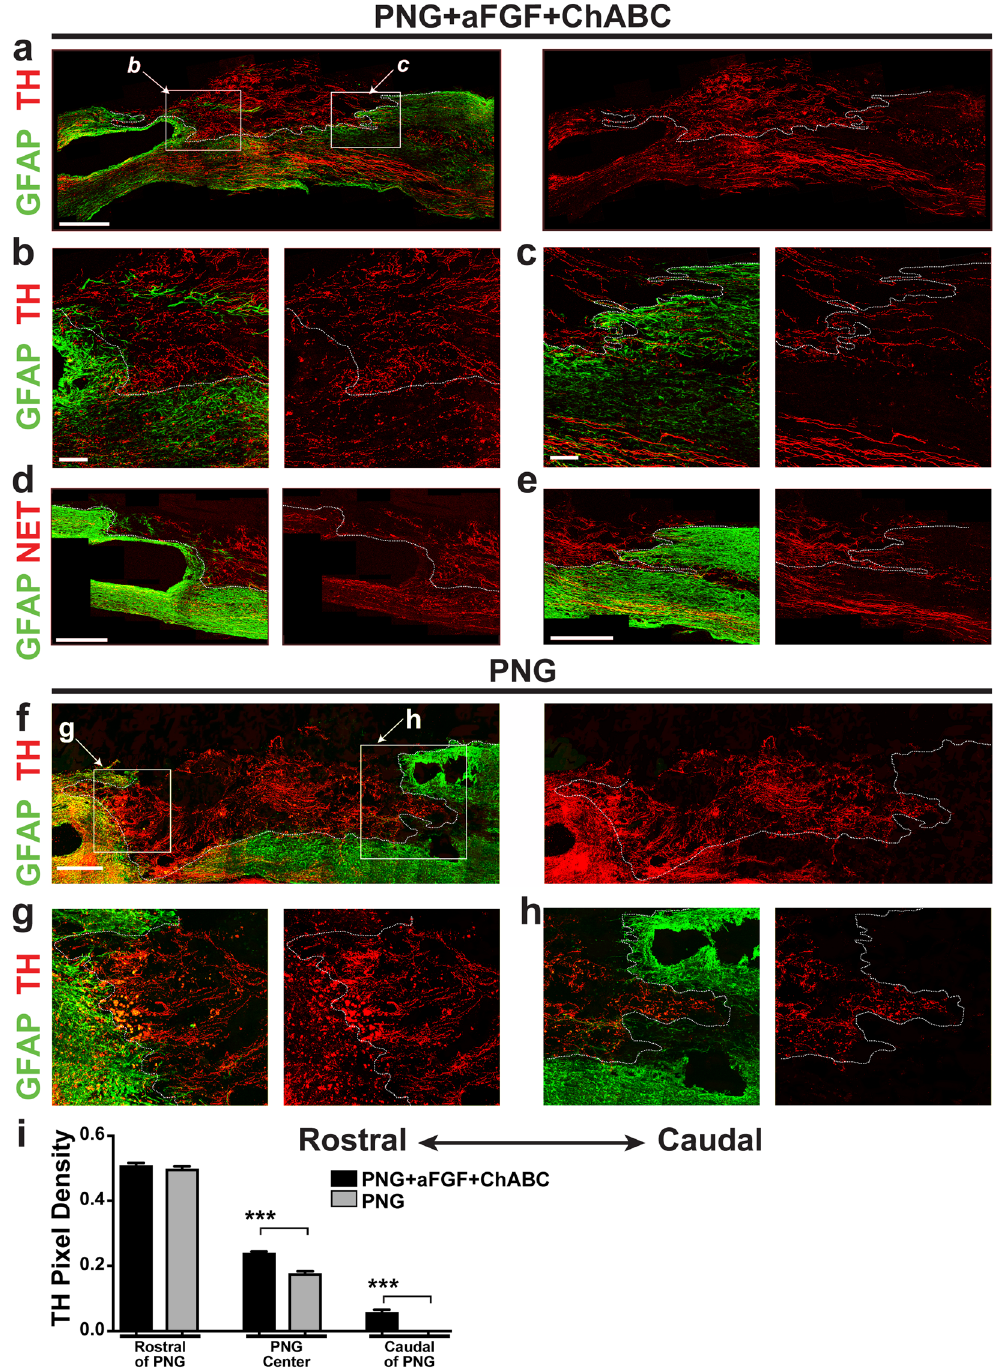
Figure 2. TH + nerve fibers regenerate through a PNG and re-enter the distal spinal cord following PNG + aFGF + ChABC treatment. ( a – e ) Images are from PNG + aFGF + ChABC-treated animals. The dotted line in each panel delineates the interface between the graft and spinal cord. ( a ) A representative low-magnification confocal image of a sagittal section with GFAP (green) and TH (red) staining displaying the overall anatomy of the PNG, spinal cord, and regenerating TH + axons. Scale bar, 500 µ m. ( b ) High-magnification confocal image of the rostral cord/PNG interface boxed in a. Large densities of TH + axons (red) enter the PNG (GFAP- negative area) from the rostral end of the spinal cord (green). Scale bar, 100 µ m. ( c ) High-magnification confocal image of caudal PNG/cord interface boxed in a. TH + axons (red) grow through the PNG and cross the PNG-spinal cord interface back into the caudal spinal cord (green). Scale bar, 100 µ m. ( d ) High-magnification confocal image showing NET + axons (red) entering the PNG from the rostral spinal cord (green). Scale bar, 100 µ m. ( e ) High-magnification confocal image showing NET + axons (red) exiting the PNG back into the caudal spinal cord (green). Scale bar, 100 µ m. ( f – h ) Images are from PNG-treated animals. The dotted line in each panel delineates the interface between the graft and spinal cord. ( f ) A representative